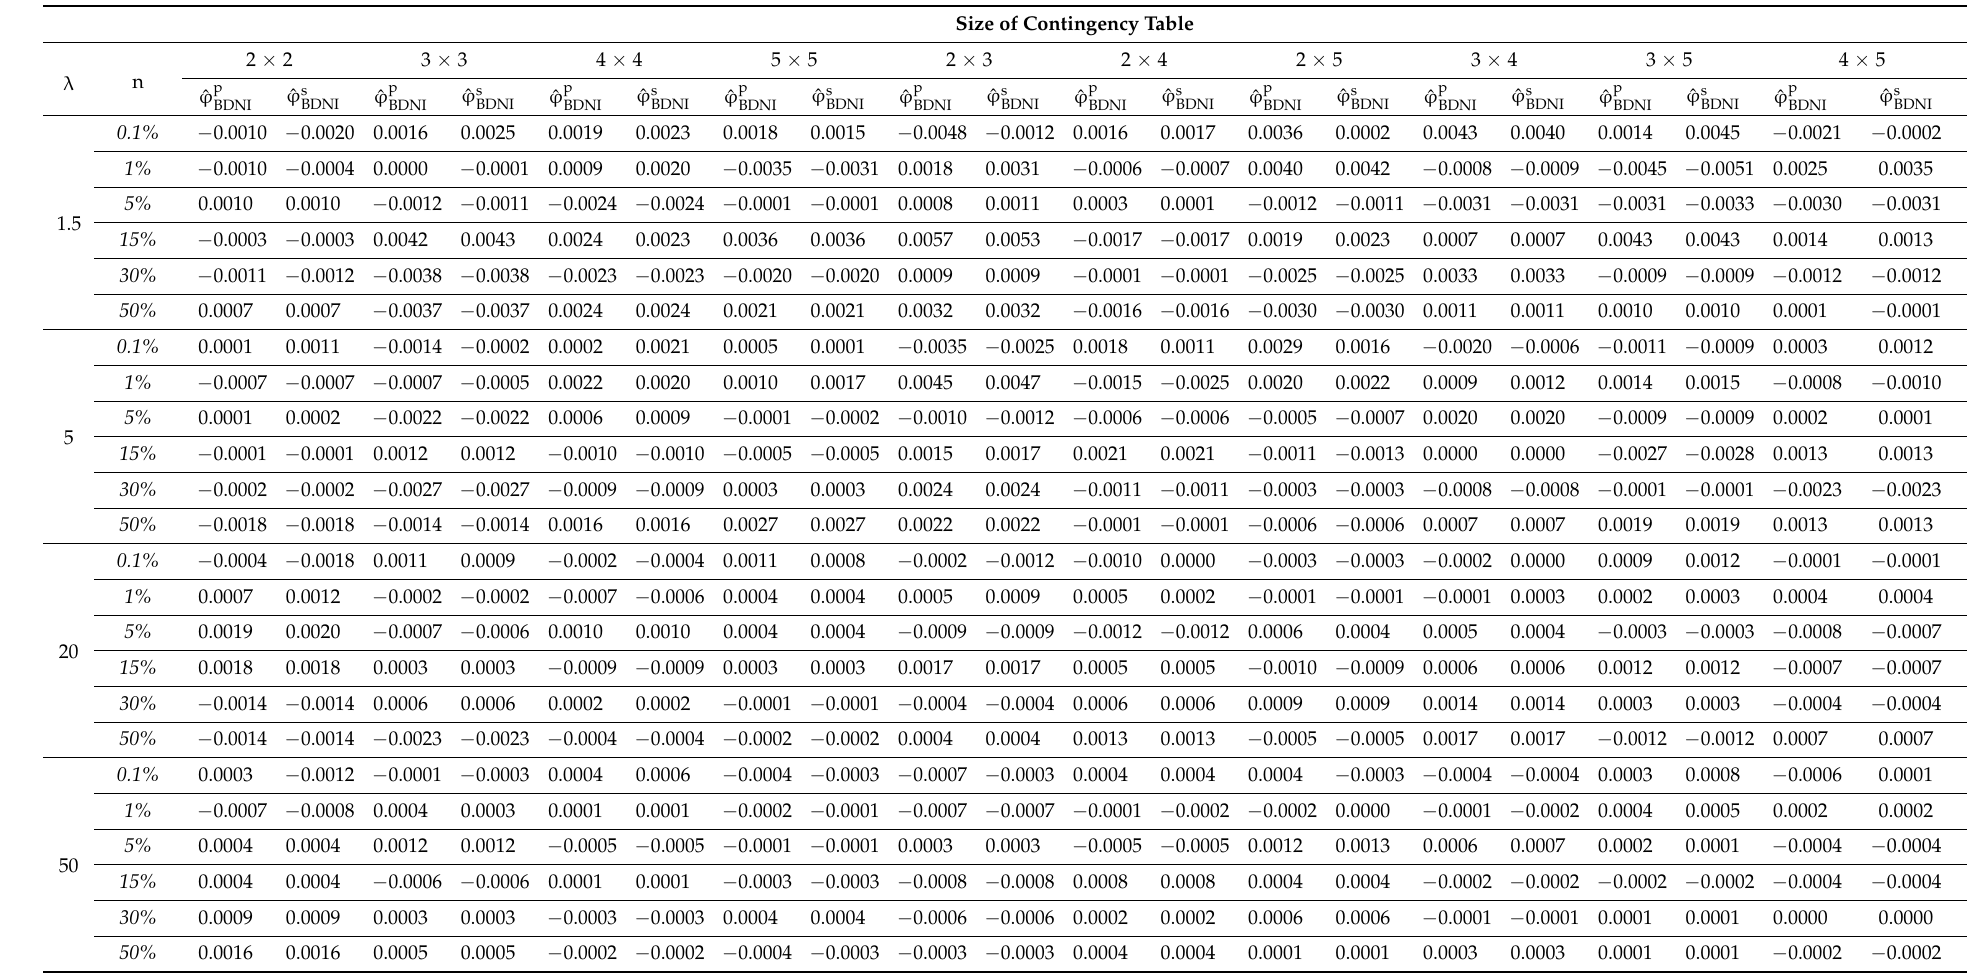
Table 2. Property of unbiasedness of ˆ ϕ BDNI for varying dimensions and λ s of simulated contingency